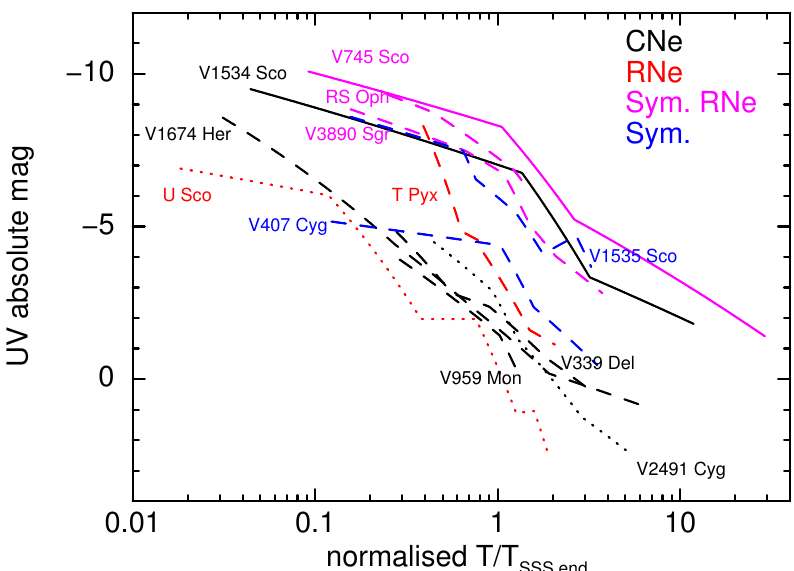
Figure 16. Power-law fits to the UVOT light-curves, converted to absolute magnitude, and plotted against time normalised to the end of the SSS. In the case where a nova was observed in multiple filters, the best sampled curve is shown. Classical novae are plotted in black, short-period recurrent nova in red, long-period recurrent novae with RG companions in magenta, and non-recurrent symbiotic-like systems (those with giant companions) in blue. Solid lines mark the light-curves collected using the uvw 1 filter, dashed— uvm 2 and dotted— uvw